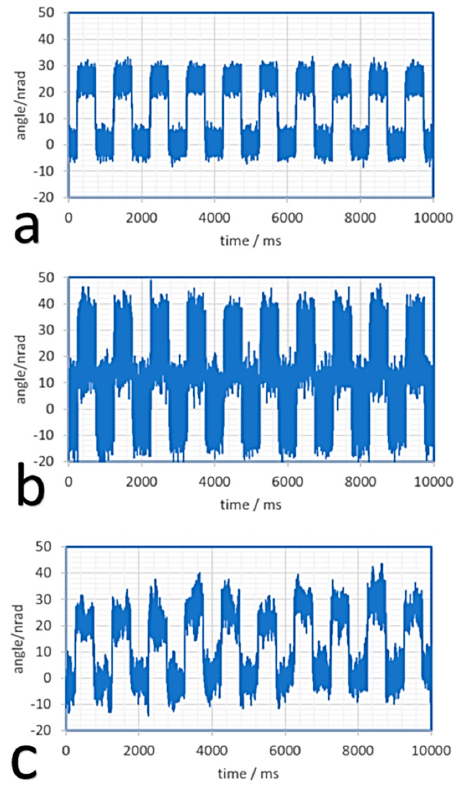
Figure 4. Time domain characterization of the MTA-2. The sensor is driven with a square wave having amplitude 25 nrad p.p. and 1 Hz frequency. In ( a ) the output of the MTA monitor filtered at 30 Hz; in ( b ) the same output filtered at 1 kHz; in ( c ) the output of the AA filtered at 1 kHz. Sensors 2020 , 20 , x FOR PEER REVIEW